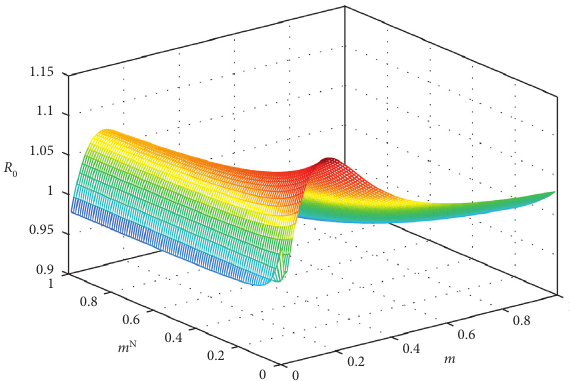
Figure 8: The effects of the diffusion rates on the net reproduction Figure 5: The effects of the diffusion rates on the net reproduction � 1 . 0286, R � 1 . 12, K � 3, K � 3 . 5, where R number R � 1 . 0971, R � 0 . 9257, K � 3 . 2, K � 3, where R number R 0 01 02 1 2 0 01 02 1 2 d N � 0 . 18, d N � 0 . 22, and m N , m J � m A � m vary from 0.01 to 1; d N � 0 . 18, d N � 0 . 23, and m N , m J � m A � m vary from 0.01 to 1; 1 2 1 2 all other parameters are given in equation (71). all other parameters are given in equation (71).